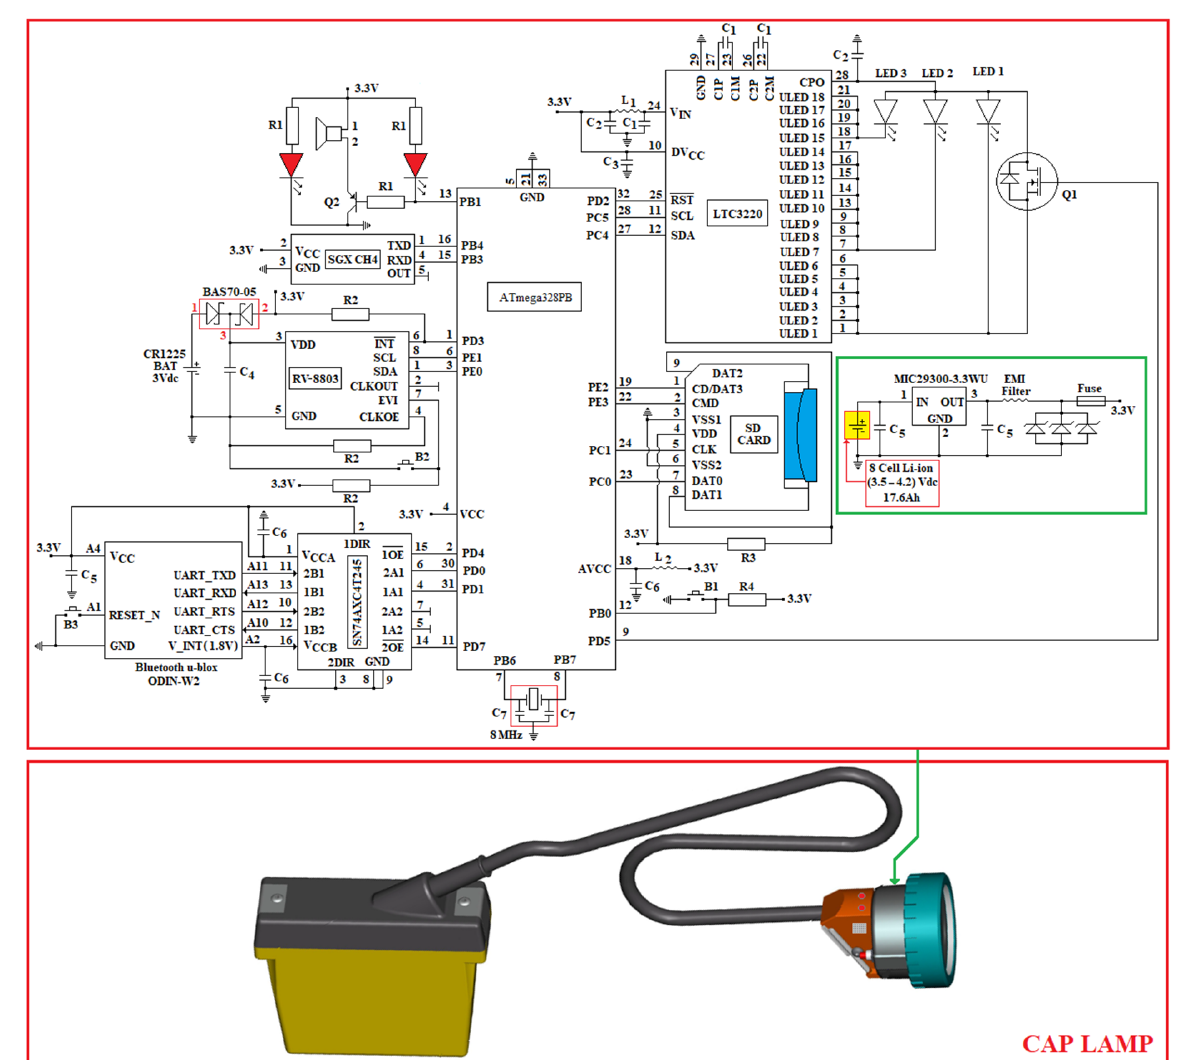
Figure 8. The miner’s cap lamp with wireless VLC technology embedded.